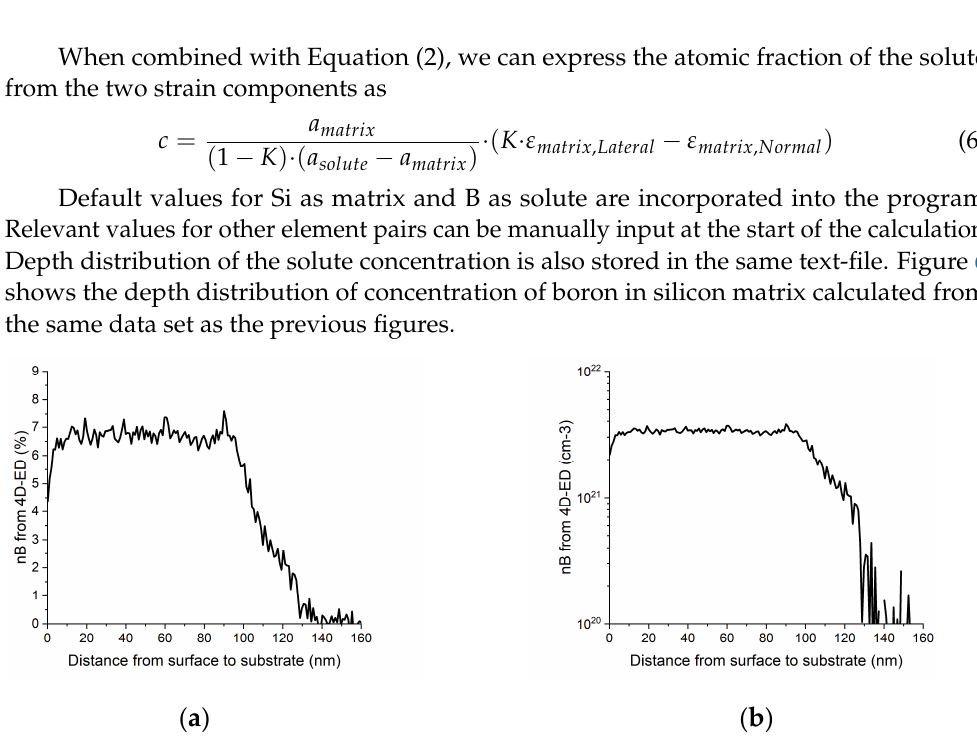
Figure 6. One-dimensional depth distribution of B in the Si:B sample. ( a ) Linear scale concentration (at%) to better show details. ( b ) Logarithmic scale (atom/cm 3 ) more usual presentation in semiconductor physics.